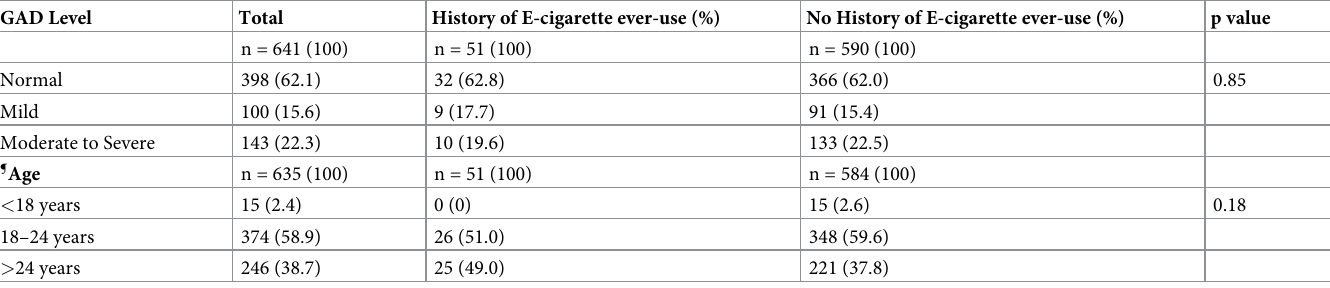
Table 3. Association between E-cigarette use and generalised anxiety disorder. GAD Level